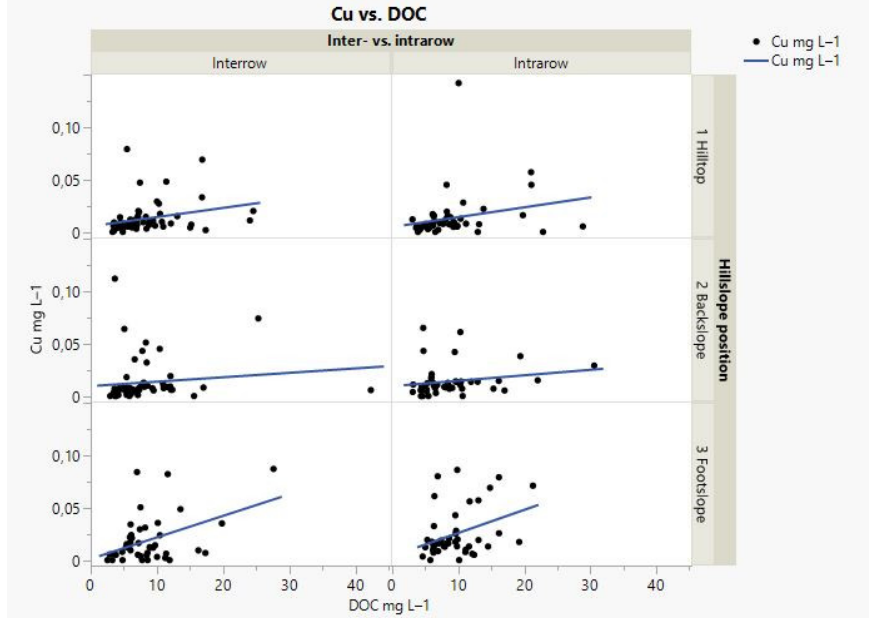
Figure 3. Graphical overlay of copper by dissolved organic carbon concentrations in leachates collected monthly for two years (2 November 2020–25 November 2022) from lysimeters installed at the hilltop, backslope and footslope of vineyard inter- and intra-row.